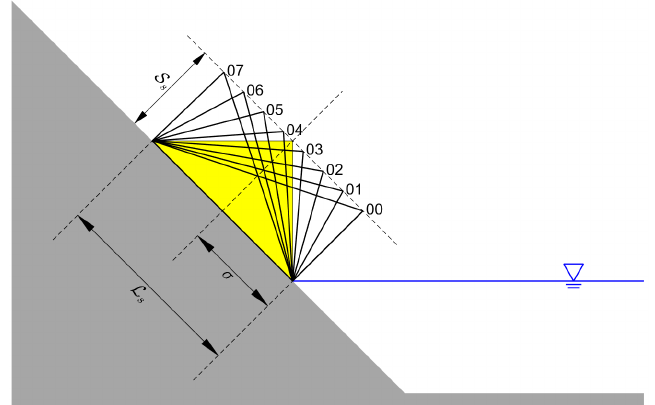
Figure 6. Sketch of triangular prism shaped model solid slides used in the numerical experiments. The two-digit code indicates the case number. The filled isosceles right triangle shows the base of the subaerial slide used in the laboratory experiments by Heinrich [51]. L s : slide length. S s : maximum slide thickness. The slide shape parameter σ measures the distance from the front vertex to the position of maximum slide thickness. Parameters of the model slides are given in Table